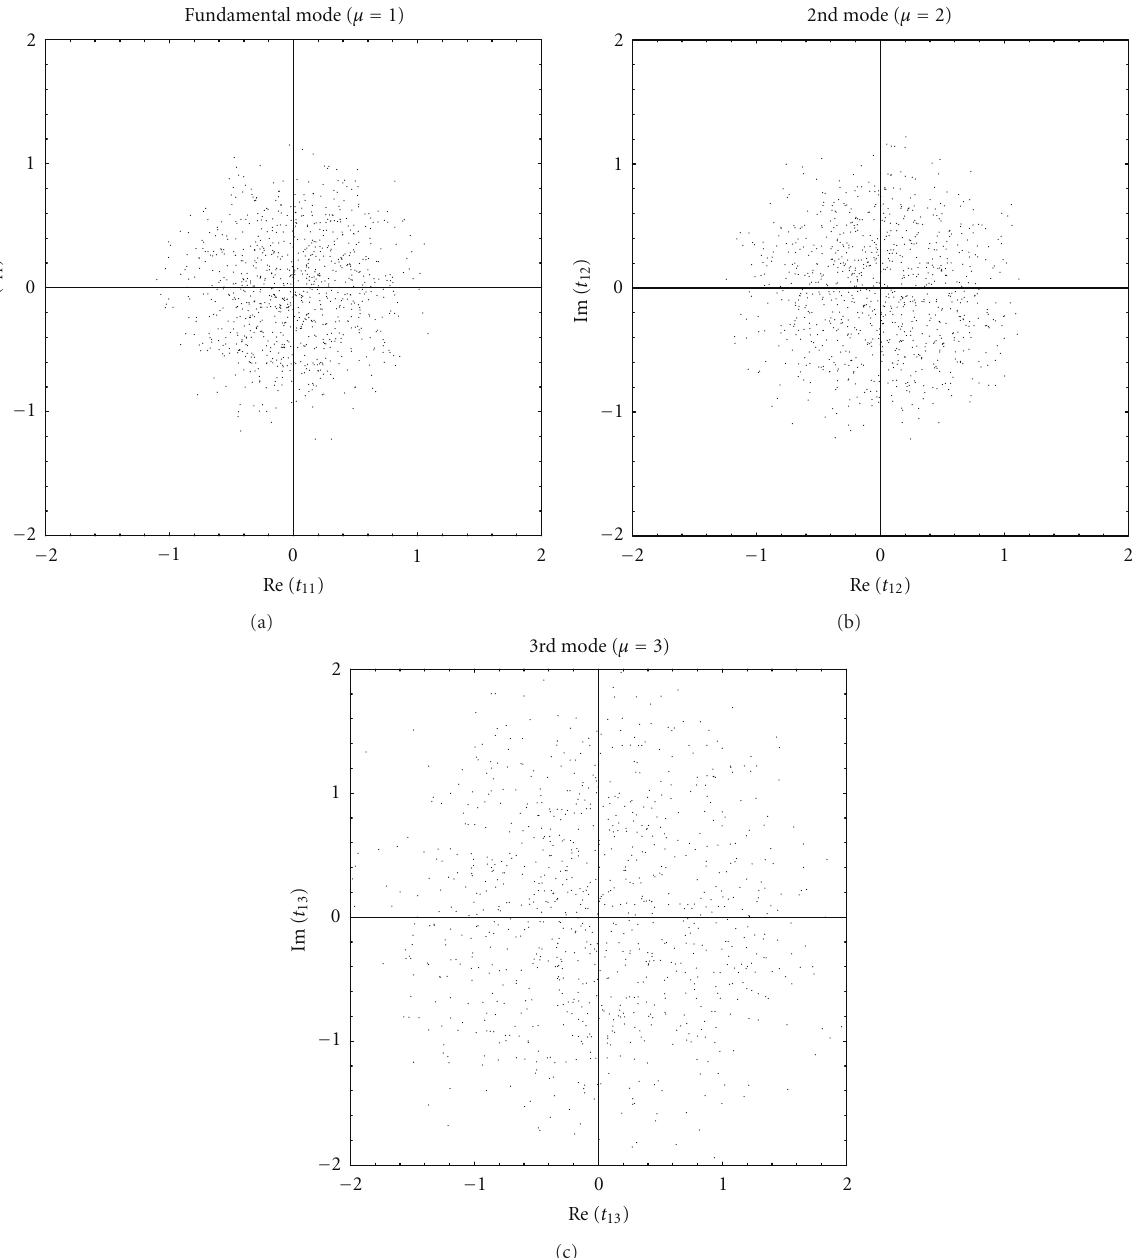
Figure 18: Plots of transmission coe ffi cients t 1 μ of the fundamental, 2nd, and 3rd modes for all samples of shape in the complex plane. The incident wave belongs to the fundamental mode; Kd =